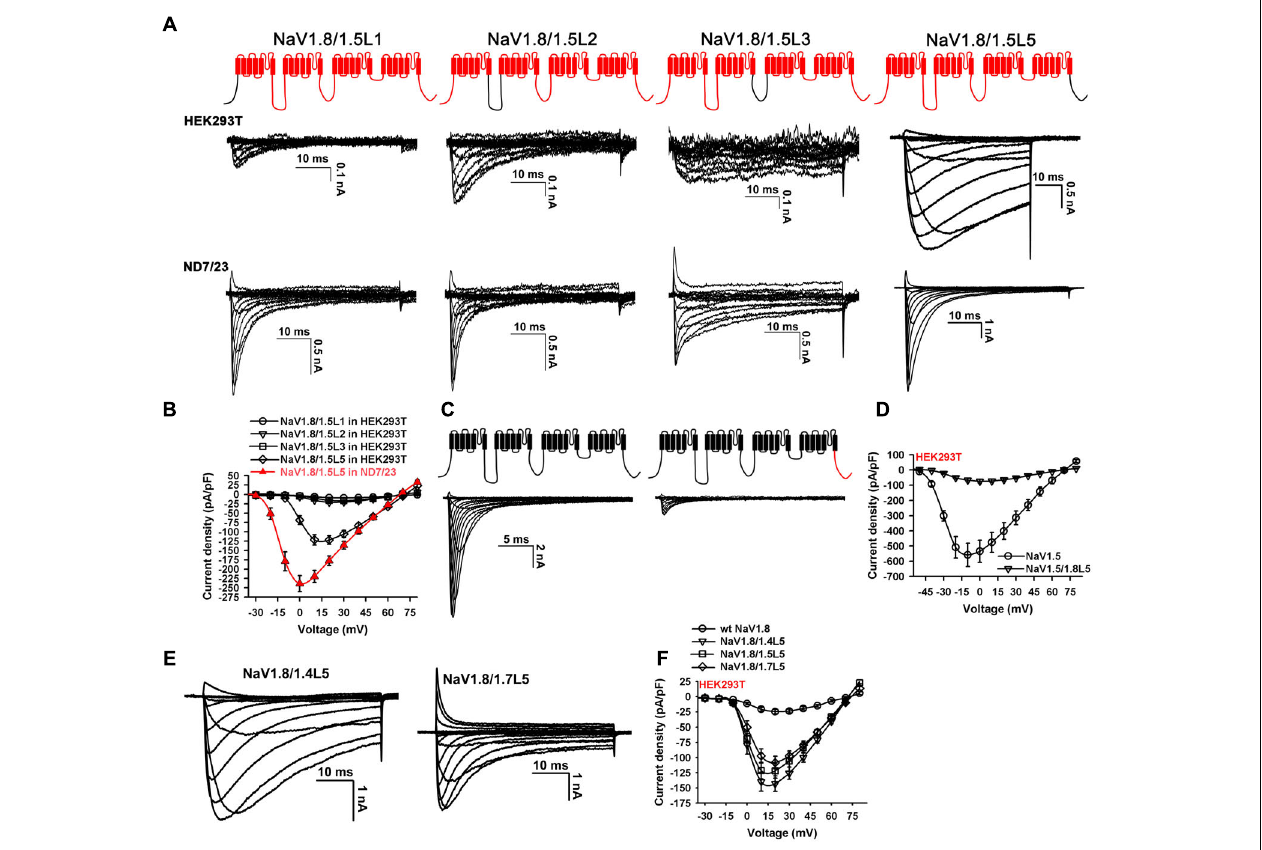
FIGURE 2 | Screening analysis of NaV1.8 intracellular loops. (A) Chimeras were constructed by replacing each intracellular loop of NaV1.8 with that of NaV1.5, family currents were elicited by testing potentials from –80 mV to 80 mV, from holding of –100 mV. NaV1.8/1.5L5 but not others expressed large currents in HEK293T cells. (B) , Current densities of channels shown in (A) , the peak current density values for NaV1.8/1.5L5 expressed in HEK293T cells and ND7/23 cells were –121.9 ± 11.8 pA/pF and –239.0 ± 24.1 pA/pF, respectively, the difference was significant ( p < 0.001, ONE-WAY ANOVA, n = 38 – 40). (C) NaV1.5/1.8L5 chimera (constructed as the cartoon illustrated), expressed much smaller currents than NaV1.5 in HEK293T cells. (D) Current densities of NaV1.5 and NaV1.5/1.8L5 in HEK293T cells, the peak values for NaV1.5 and NaV1.5/1.8L5 were –74.7 ± 11.7 pA/pF and –558.0 ± 76.9 pA/pF, respectively, the difference was significant ( p < 0.001, ONE-WAY ANOVA, n = 33 – 34). (E) Representative traces showed replacing the C-terminus of NaV1.8 with that of NaV1.4 or NaV1.7 constructed channels (NaV1.8/1.4L5 and NaV1.8/1.7L5) functionally expressed in HEK293T cells. (F) Current densities of NaV1.8, NaV1.8/1.4L5, NaV1.8/1.5L5, and